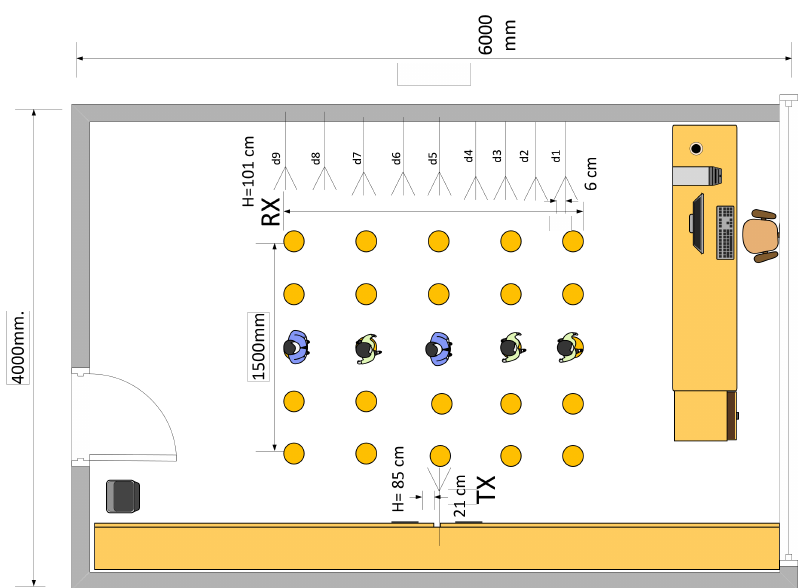
Figure 8. Deployment layout for the experimental subject counting system including N t = 1 TX and N r = 9 RX devices with M = 3 antennas for each device. Distance between antennas at receiver is 6 cm, while transmitter antennas are spaced apart by 21 cm. The monitored area size is 6 × 4 m 2 . Up to N = 5 people enter this area and walk along the middle line thus blocking the LOS path between TX and